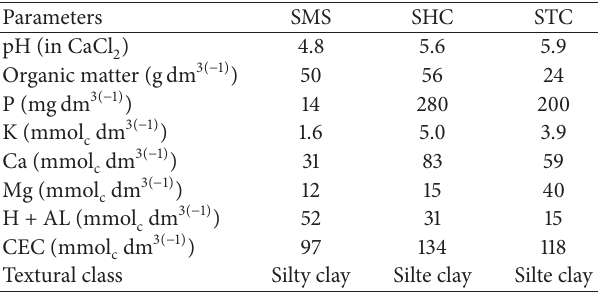
Table 1: Chemical and physical characteristics soils cultivated for vegetable (SHC) and tomato (STC) production and of forest soil